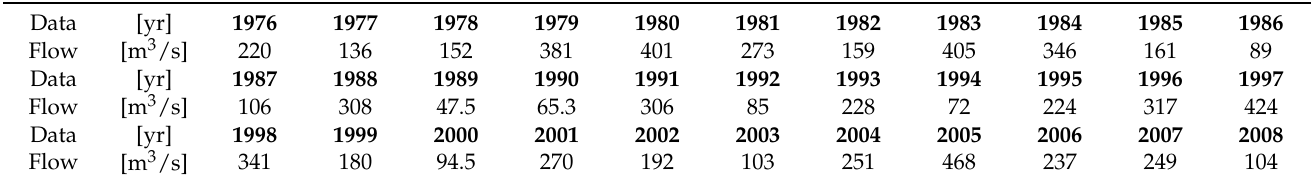
Table 1. Observed data from the Tandarei station.